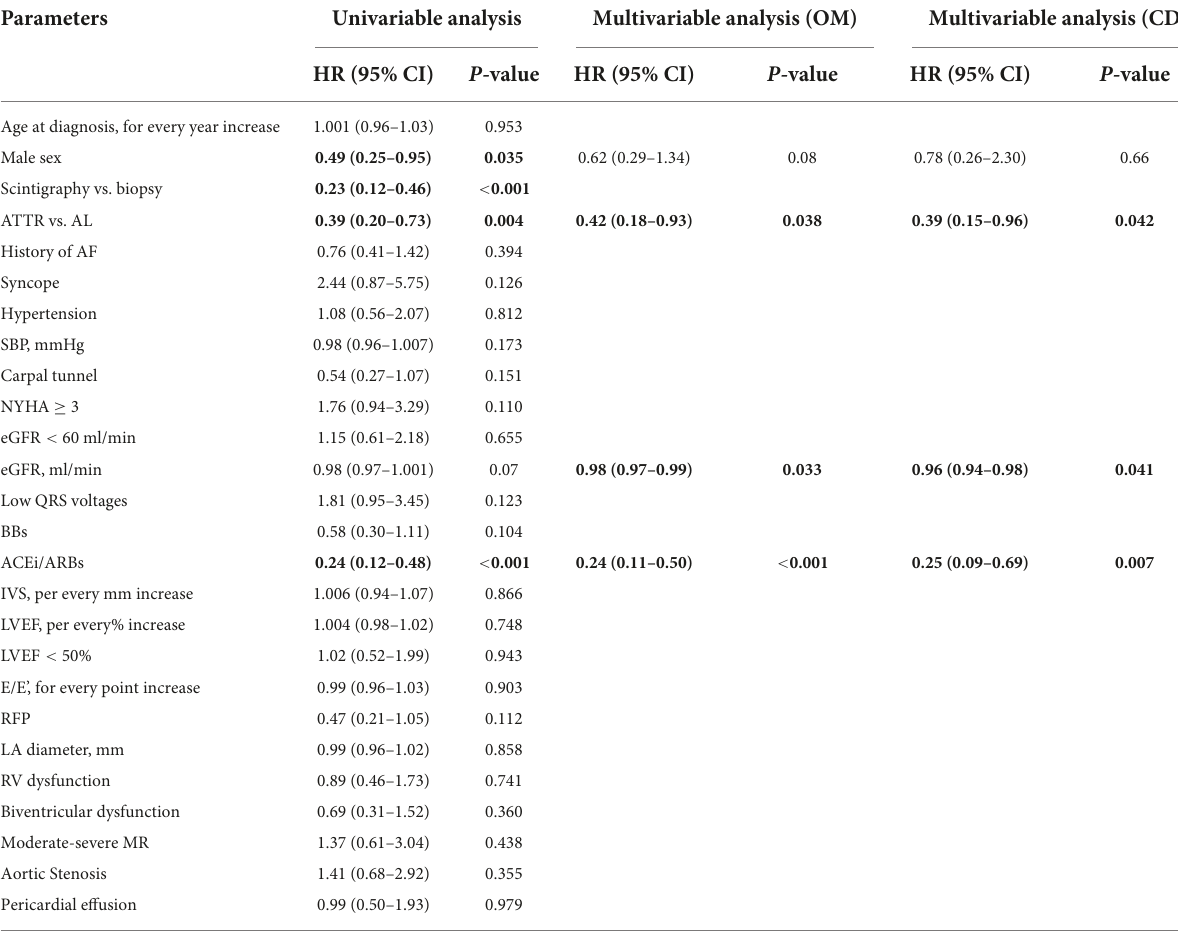
TABLE 2 Univariable and multivariable analyses for overall mortality and cardiac death in the contemporary